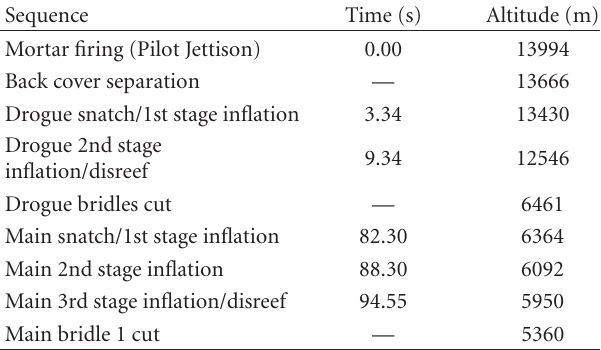
Table 1: The parachute deployment